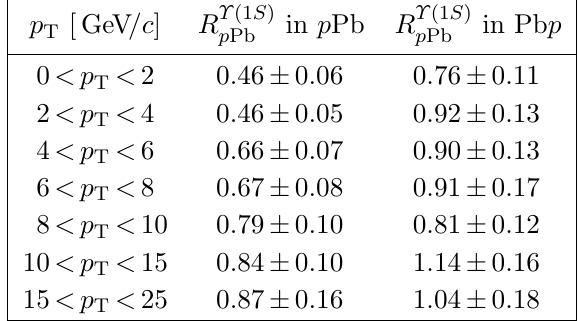
Table 12 . (cid:7) (1 S ) nuclear modi(cid:12)cation factor, R (cid:7) (1 S ) over y (cid:3) in the range 1 : 5 < y (cid:3) < 4 : 0 for p Pb and (cid:0) 5 : 0 < y (cid:3) < (cid:0) 2 : 5 for Pb p .